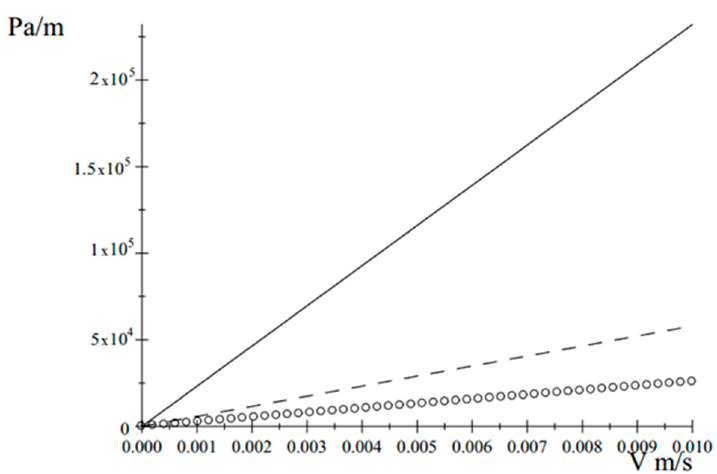
Figure 6. Particle size effect with ε = 0.4, d p = 0.1 m, and ϕ = 0.01 (solid line), 0.02 (dashed line), 0.03 (dotted line).